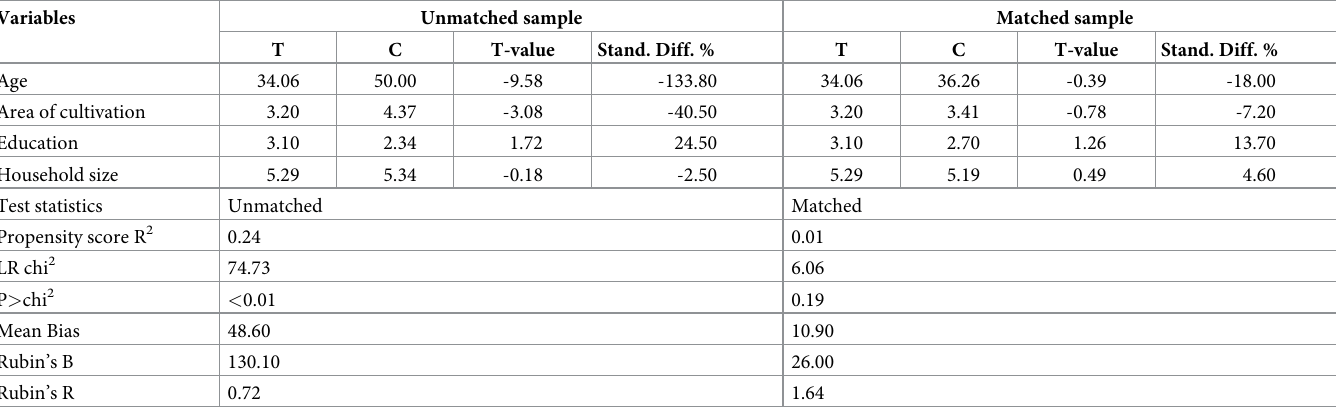
Table 5. Covariate balance for the good vision and poor vision groups before and after